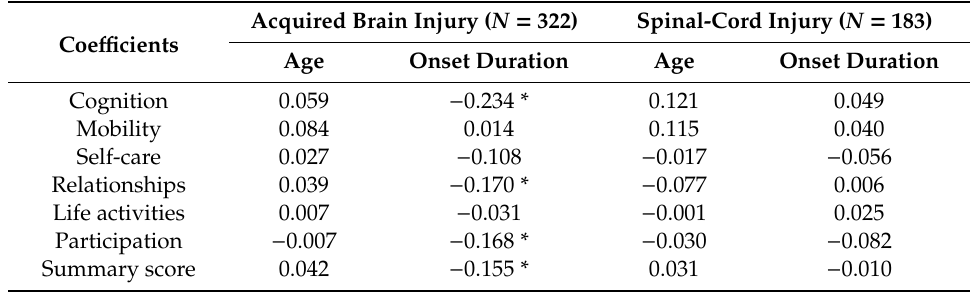
Table 5. Linear regression analyses with WHODAS 2.0 scores as the dependent variable.